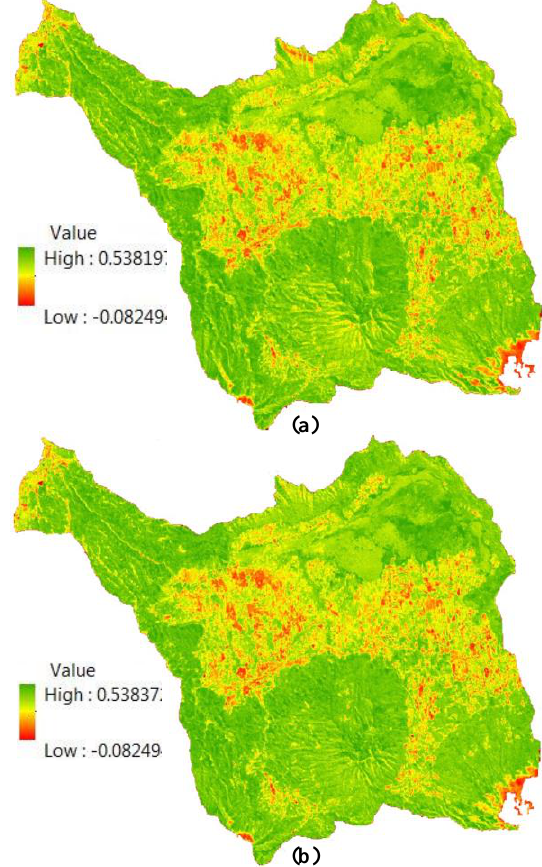
Figure 8. Reflectance of band 6, (a) before and (b) after topographic correction